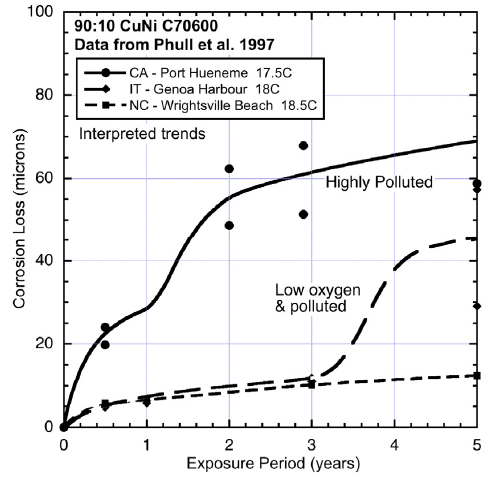
Figure 4. Data and interpreted trends for cool seawater sites EN and NJ.